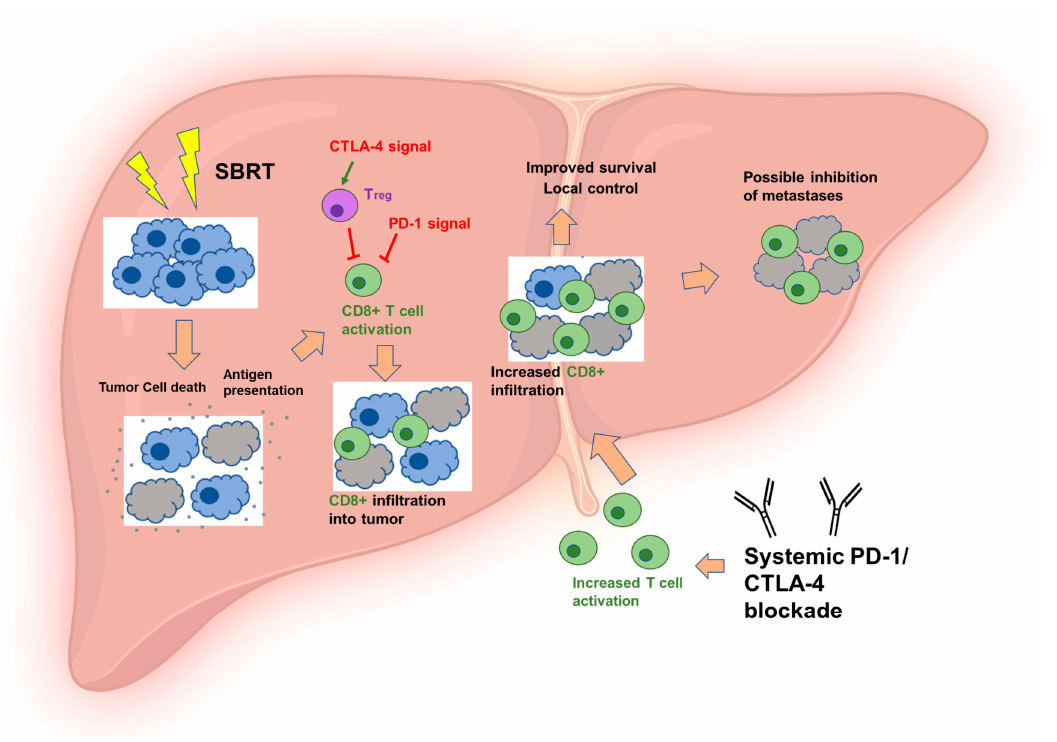
Figure 1. Synergistic effect of immunotherapy and SBRT on advanced liver tumors. SBRT—stereotactic body radiation therapy; PD-1—programmed death 1; CTLA-4—cytotoxic T-lymphocyte-associated antigen-4.